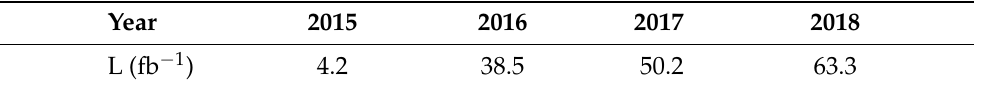
Table 25. LHC-delivered luminosities in Run-2 during 2015 to 2018 operation. Taken from Ref.